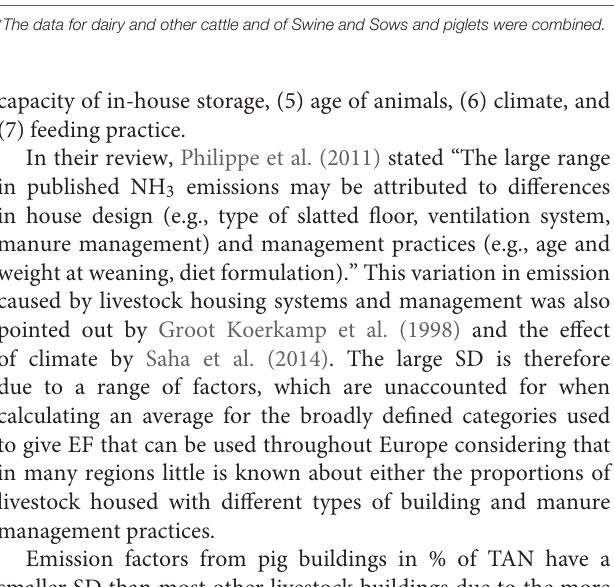
Dairy cows* Swine—fatteners (8–110kg)* Sows and piglets up to 8 kg*